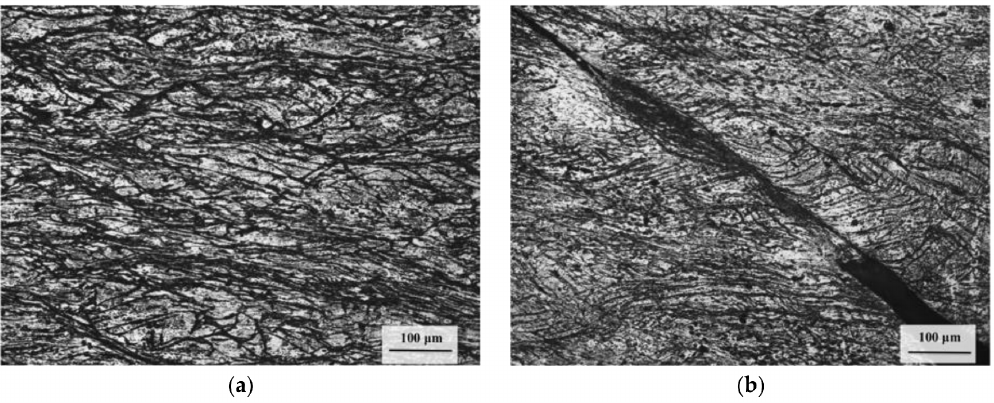
Figure 13. Microstructures of specimens compressed under the conditions of flow instability regime. The compression axis is vertical. ( a ) 300 ◦ C and 0.1 s − 1 ; ( b ) 300 ◦ C and 1 s − 1